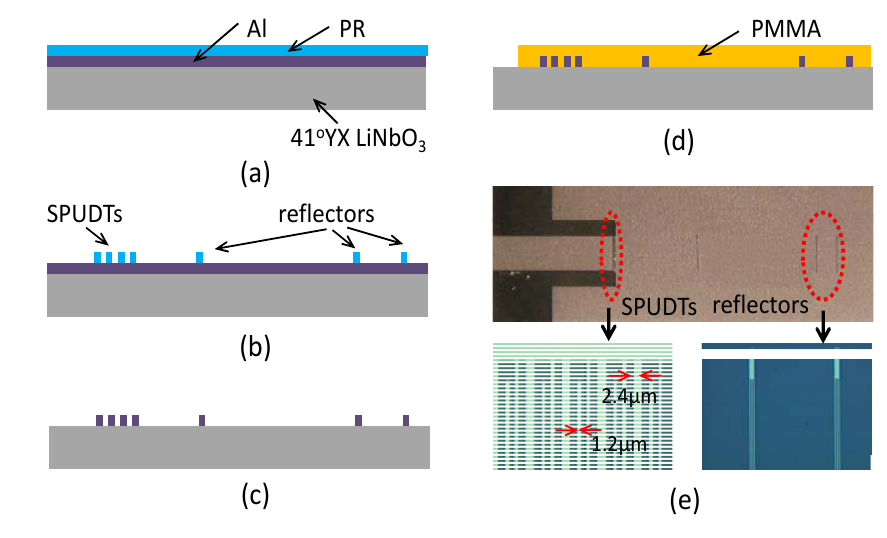
Figure 7. Fabrication procedure of the Love wave reflective delay line (a) Al and PR coating, (b) development, (c) Al etching, (d) PMMA spin-coating, and (e) optical image of the fabricated Love wave